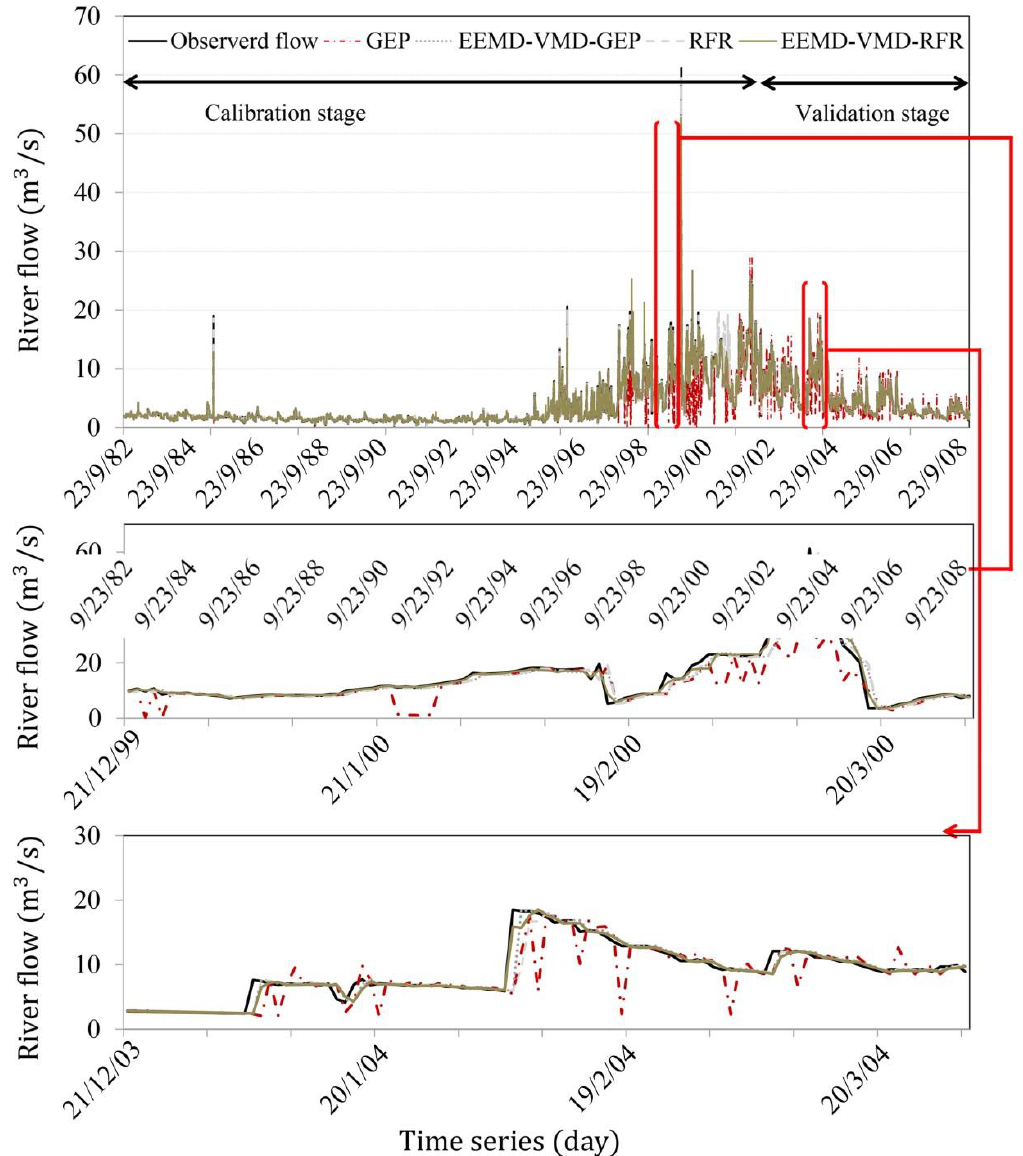
Figure 12. A time-series of observed and forecasted daily streamflow of ensemble EEMD-VMD-GEP and EEMD-VMD-RFR models compared with standalone GEP and RFR models for the calibration and validation periods at the Gachsar station.